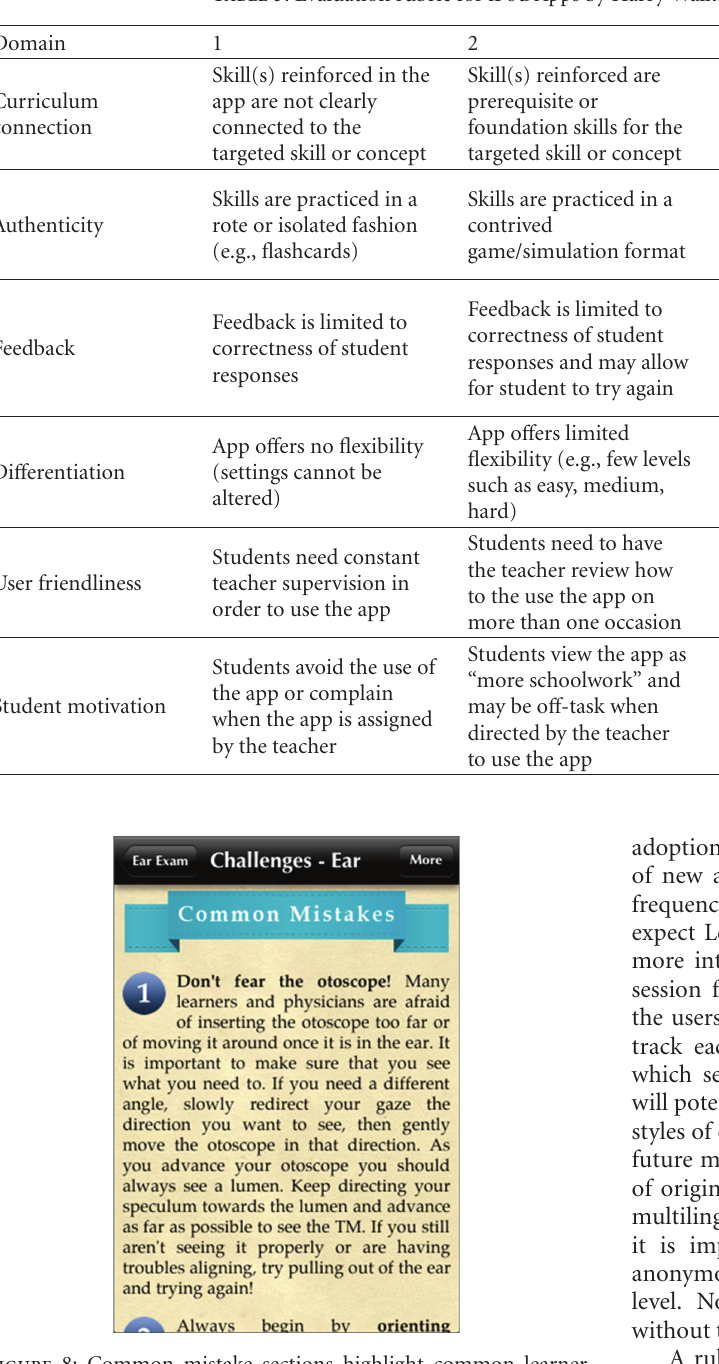
Table 3: Evaluation rubric for iPod Apps by Harry Walker. Reproduced with permission.